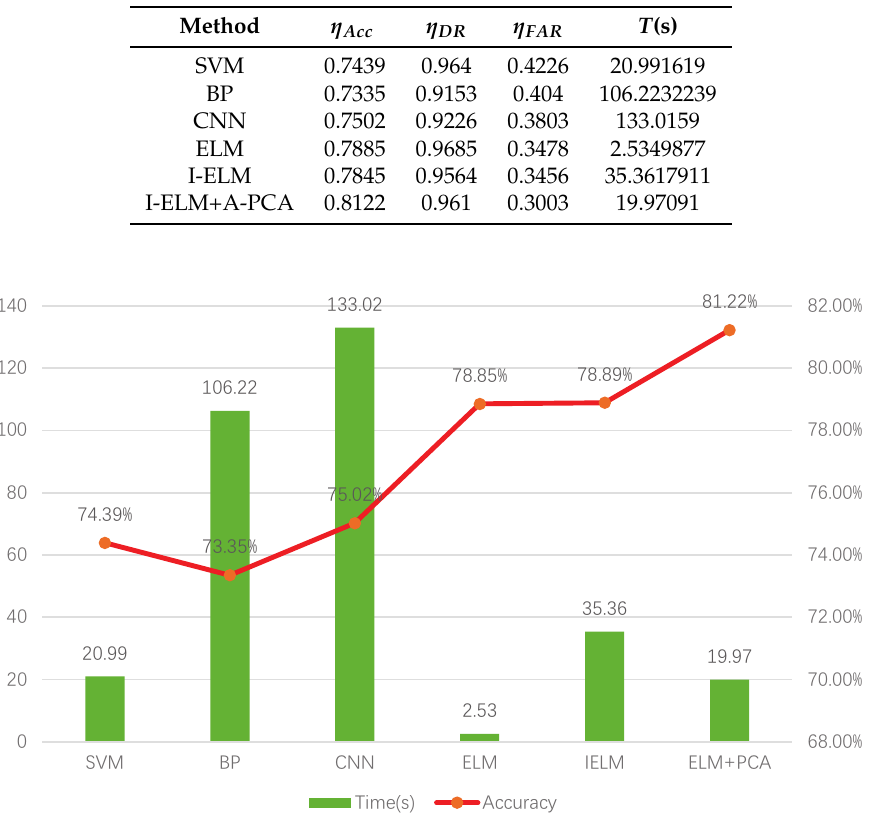
Table 14. The values of evaluation criteria of different detection algorithms (NSL-KDD).